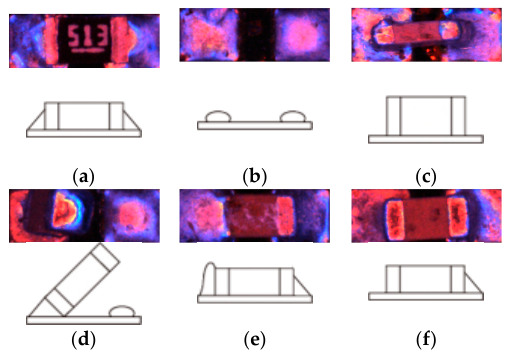
Figure 1. Defects in the surface mount technology (SMT) assembly line: ( a ) normal ( b ) missing ( c ) Manhattan ( d ) Tombstone ( e ) over-solder, and ( f ) under-solder.